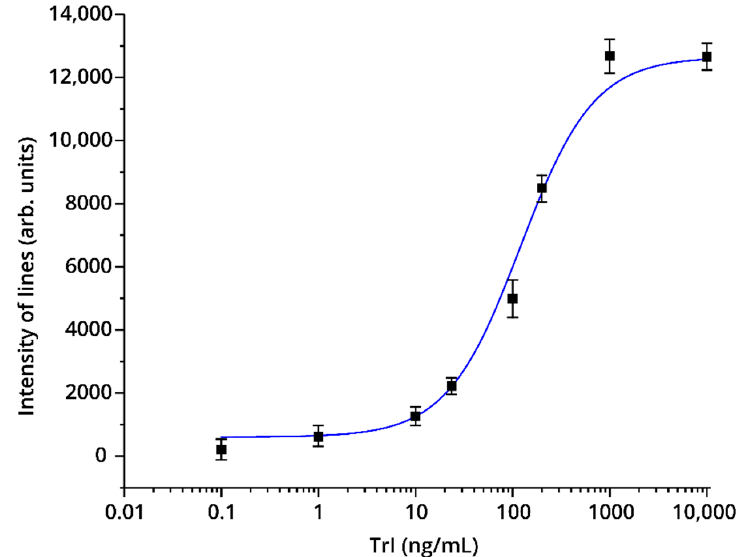
Figure 6. Calibration curve for determining bovine skeletal TnI by LFIA in PBST containing 0.5 M KCl (Variant No. 2 of the test system).